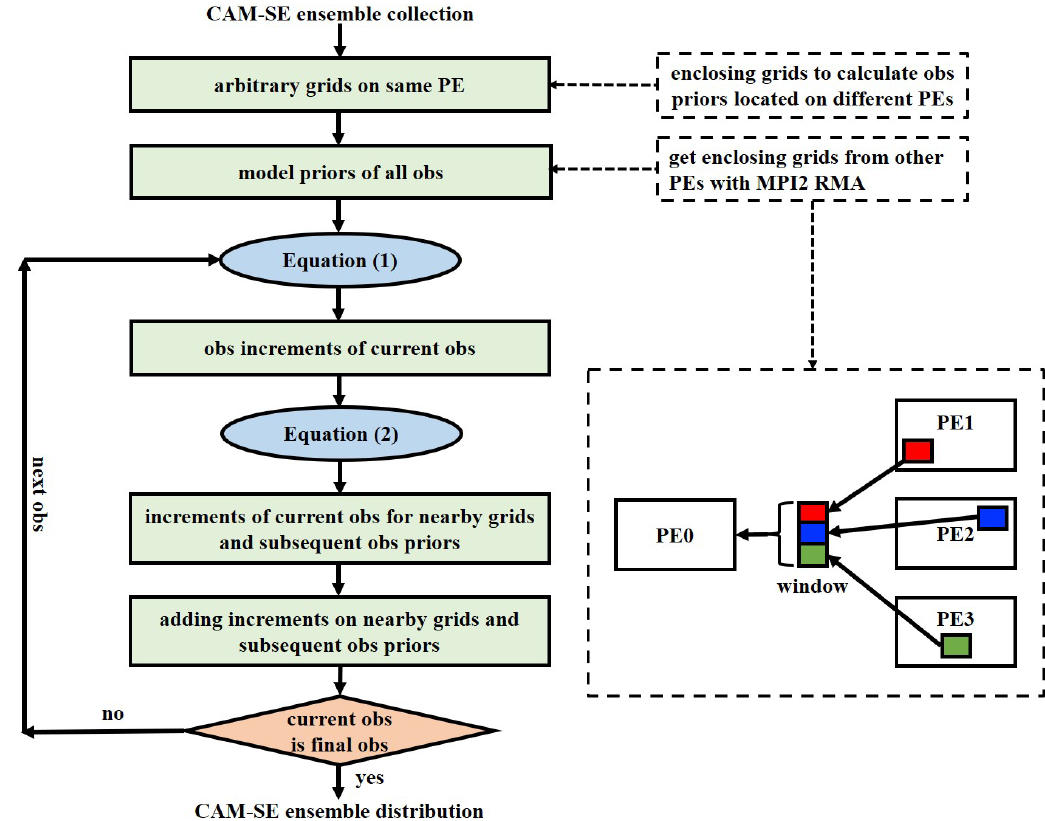
Figure 3. Schematic of the implementation of the parallel EAKF algorithm with CAM-SE. The implementation is also based on the two-step method of EAKF. In CAM-SE, the grid points are decomposed onto the analysis PEs in an arbitrary way. Therefore, the computation of the forward observation operator may need to obtain values from other PEs, which is realized through the MPI2 RMA technique. The lower-right dashed rectangle illustrates an example of grabbing data from PEs 1–3 to PE0 via a virtual window of RMA. When the observations at a given time are available, the prior ensembles for all observations are computed. The observational increments of an observation regress not only on the nearby model states, but also on the subsequent observation prior